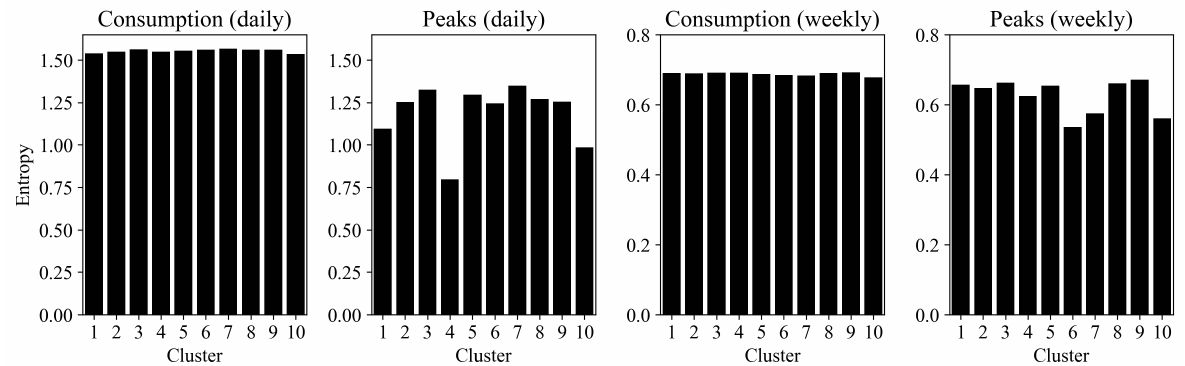
Figure 11. Mean values of the calculated entropy of the distributions of the normalized consumption and peak demands at the daily and weekly level of the individual consumers populating each